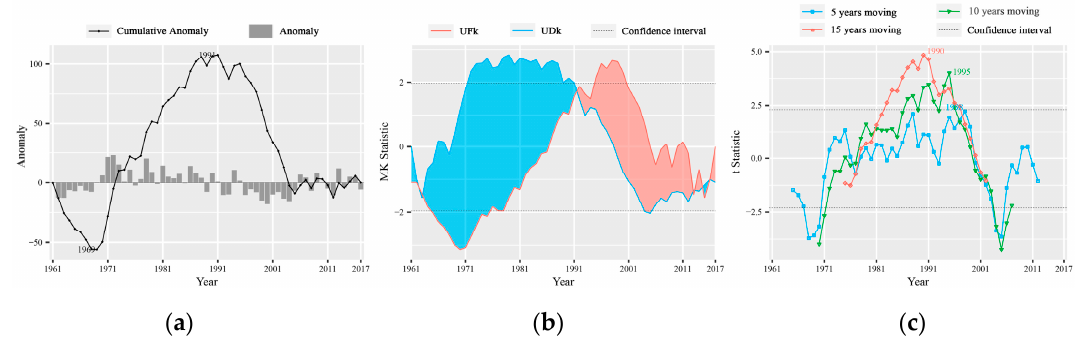
Figure 4. The abrupt change point identification diagram of summer ET 0 sequence, where the picture category of the ( a – c ) is same to Figure